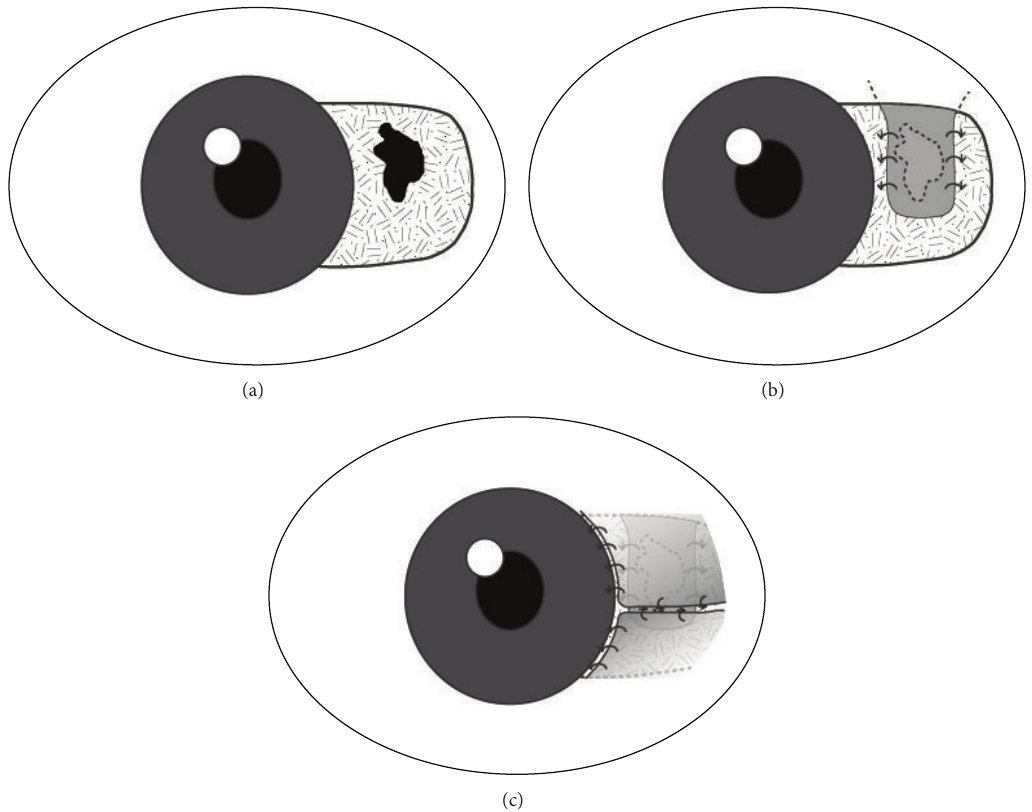
Figure 1: Diagram of the surgical procedure. (a) Area of scleral thinning. (b) Advanced tenon flap harvested from the superonasal site of the scleral thinning and complete covering of the scleromalacia boundary. (c) Sliding conjunctival flap was made over the area of the tenon graft with fixation sutures between conjunctiva and sclera.